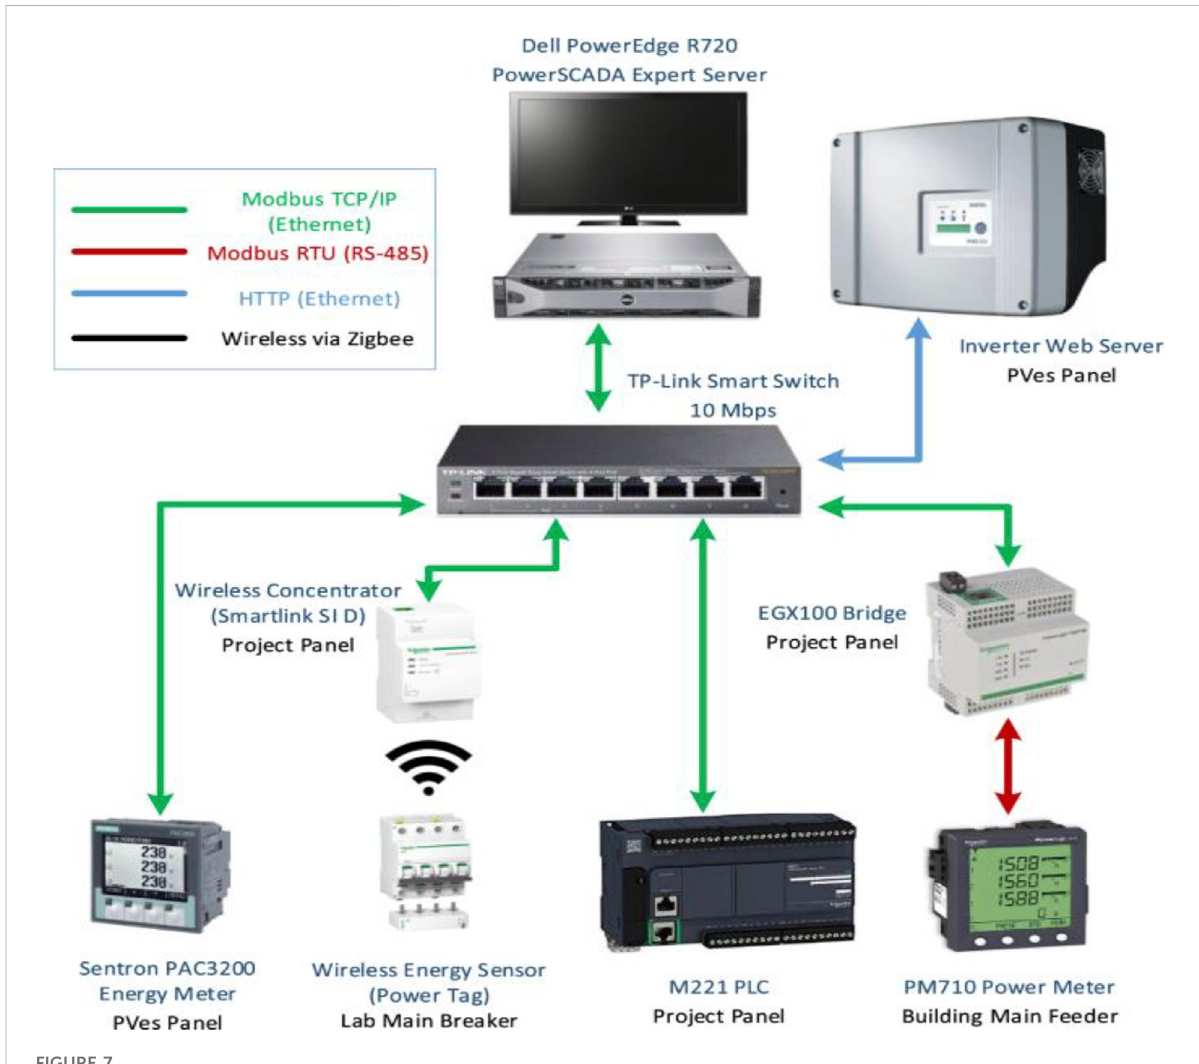
FIGURE 7 SCADA Monitoring system for microgrid (Marinakis and Doukas,